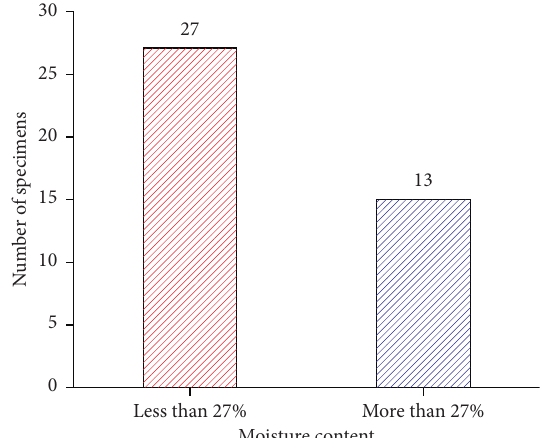
Figure 10: Distribution of undistributed soil specimens under different moisture content.